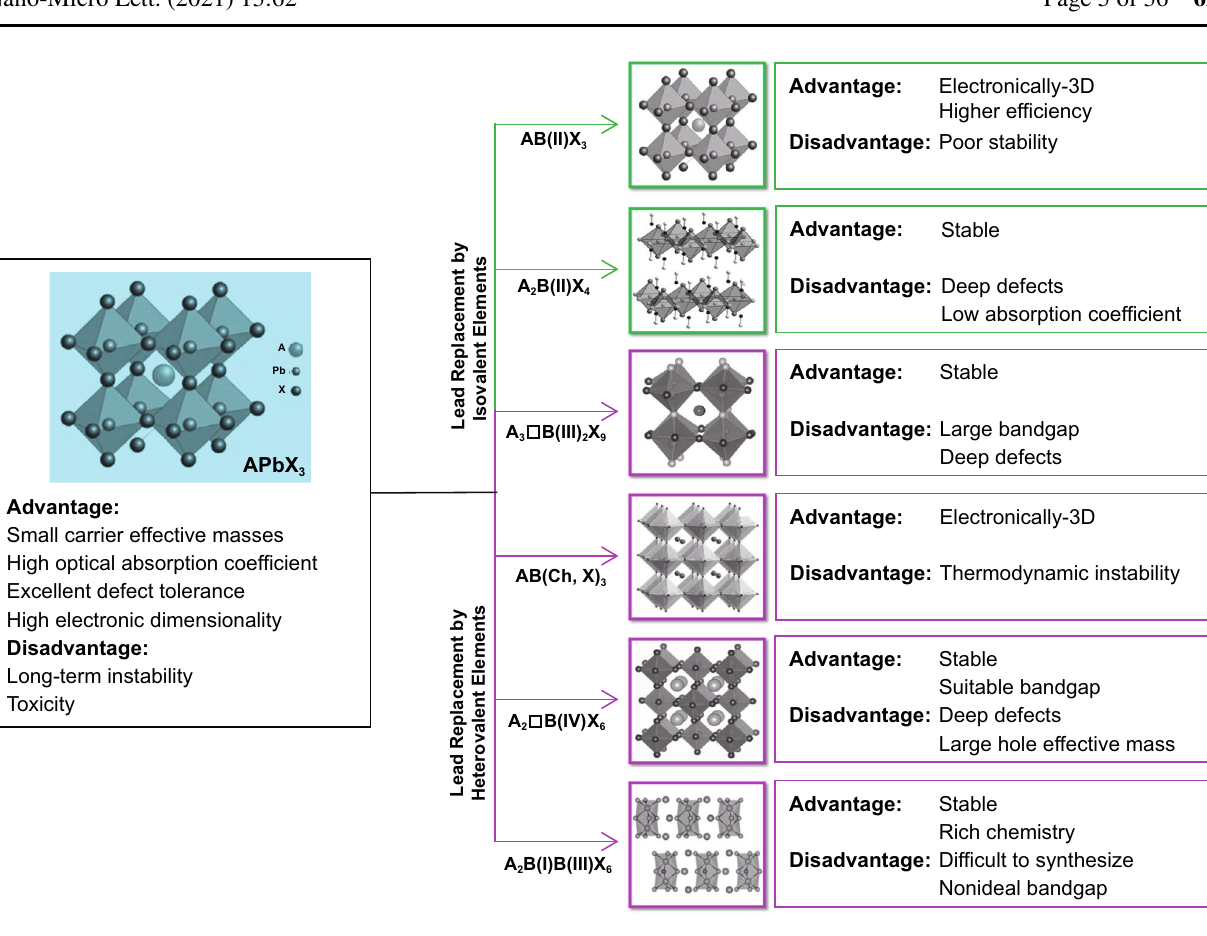
Fig. 2 Schematic illustration of the approaches and consequences of potential Pb